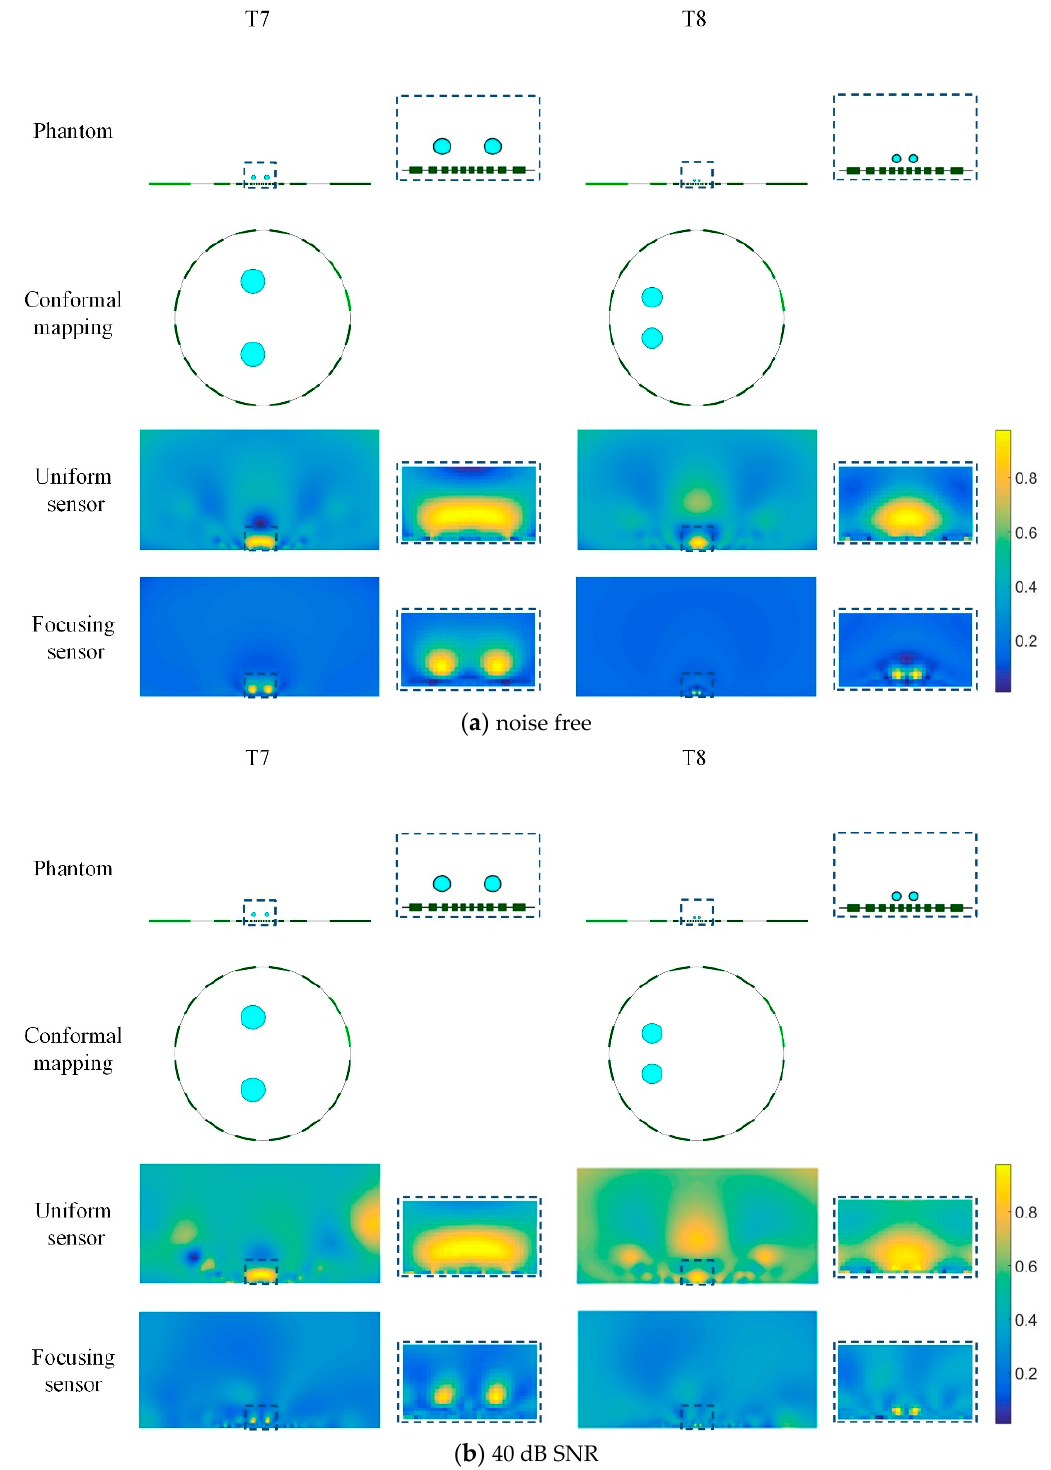
Figure 13. Reconstruction results of double targets based on uniform and focusing sensors with noise free data and 40 dB SNR data.